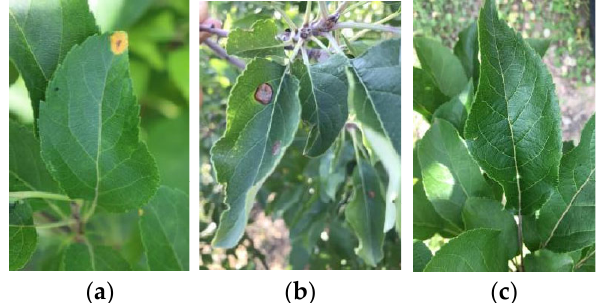
Figure 1. Example of apple leaf images: ( a ) rust; ( b ) ring rot; ( c )healthy.